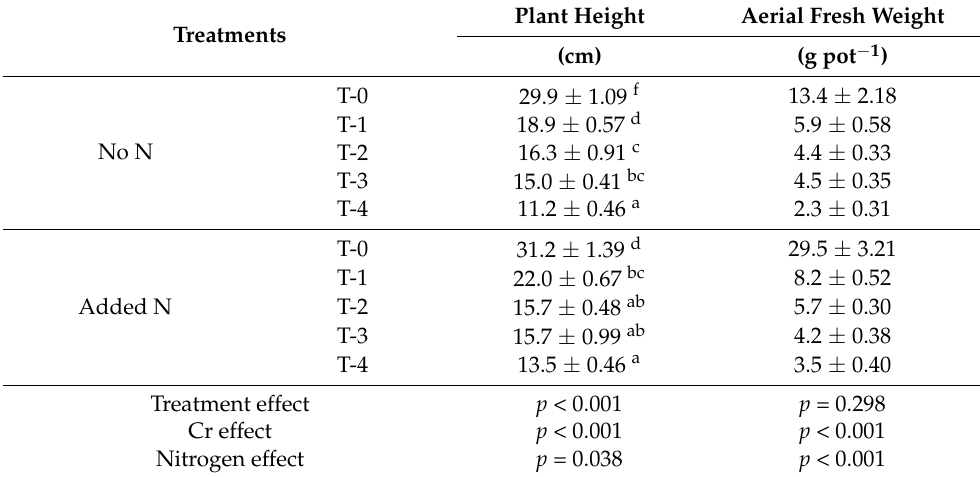
Table 1. Plant height and aerial fresh weight at harvest date.